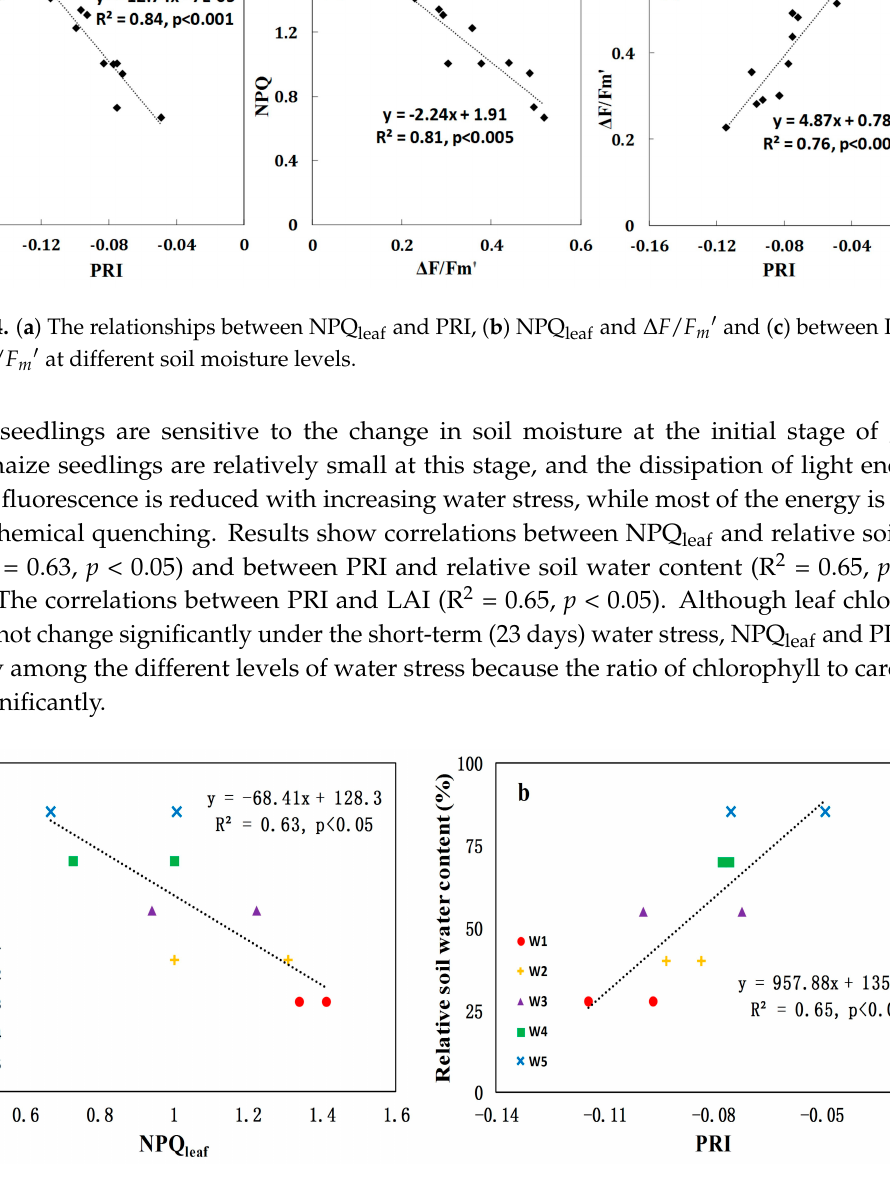
Figure 5. ( a ) Correlations between NPQ leaf and relative soil water content (R 2 = 0.63, p < 0.05) and ( b ) between photochemical reflectance index (PRI) and relative soil water content (R 2 = 0.65, p < 0.05).